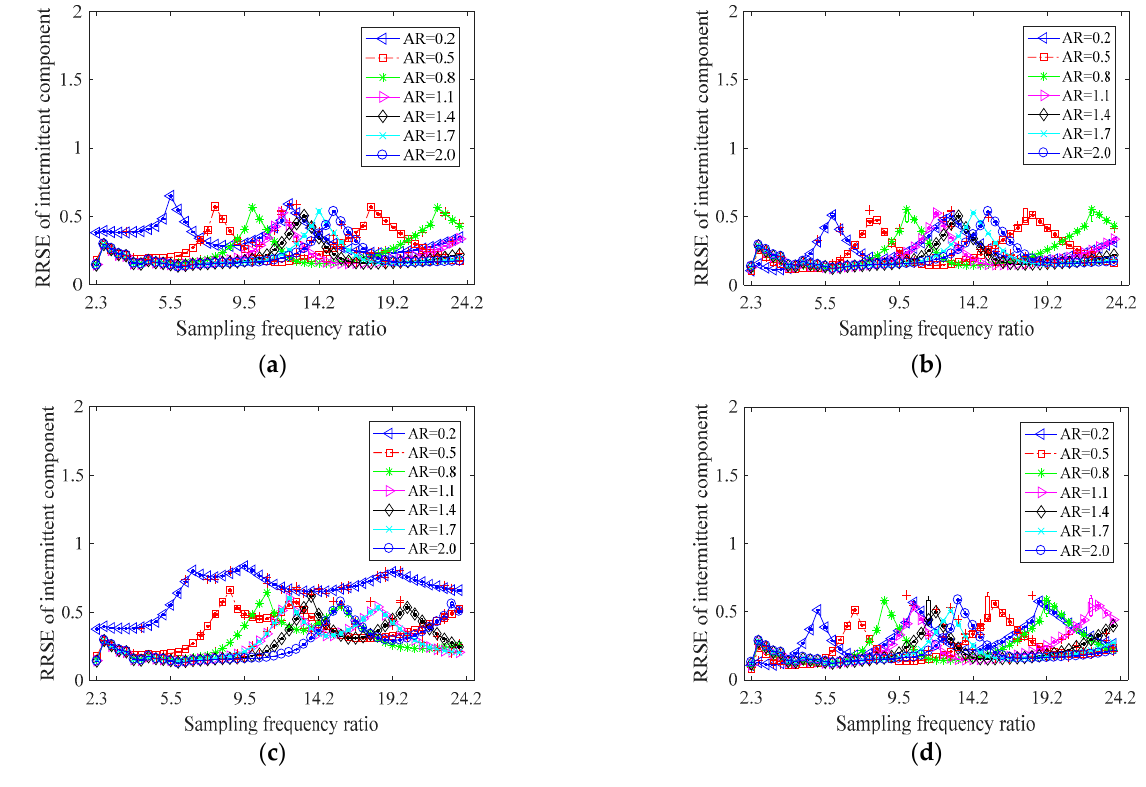
Figure 4. RRSE of the intermittent component for four noise-assisted EMD algorithms: ( a ) EEMD; ( b ) CEEMD; ( c ) CEEMDAN; ( d ) ICEEMDAN.